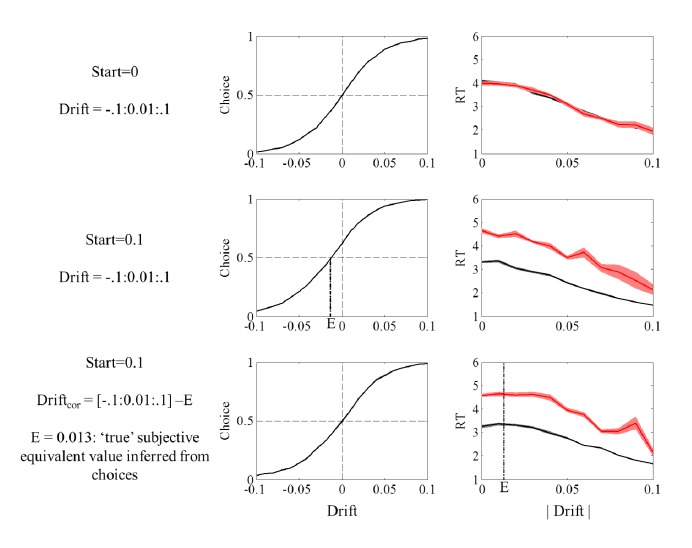
DOI:
http://dx.doi.org/10.7554/eLife.20317.012